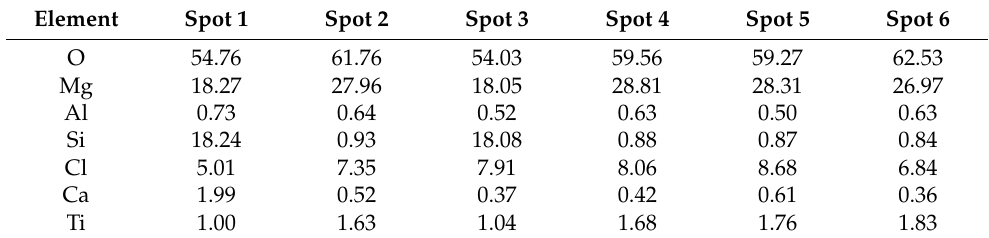
Table 1. EDS analysis of PFWC-439 (at%).